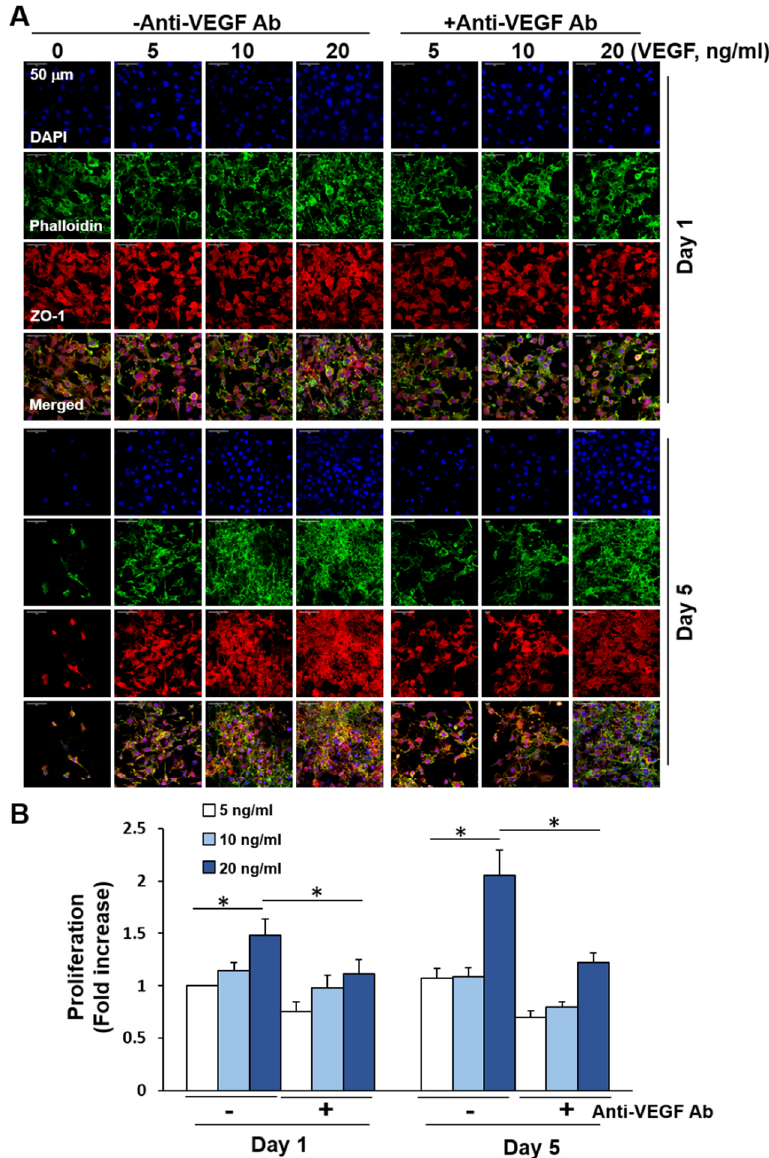
Figure 6. Growth regulation of bEND.3 ECs cultured on C / DMF-PCL-M by VEGF. bEND.3 cells (3 × 10 4 ) were cultured with VEGF at increasing concentrations in the presence ( + Anti-VEGF Ab) or absence ( − Anti-VEGF Ab) of anti-VEGF antibody (0.6 µ g / mL) for 1 d and 5 d ( n = 3). ( A ) Cell morphology was assessed via confocal microscopy. Images represent three fields in each membrane. ( B ) The cell proliferation rate was analyzed using the CCK-8 assay and presented as a fold increase. Data are presented as mean ± SD values ( n = 3). * p < 0.05.